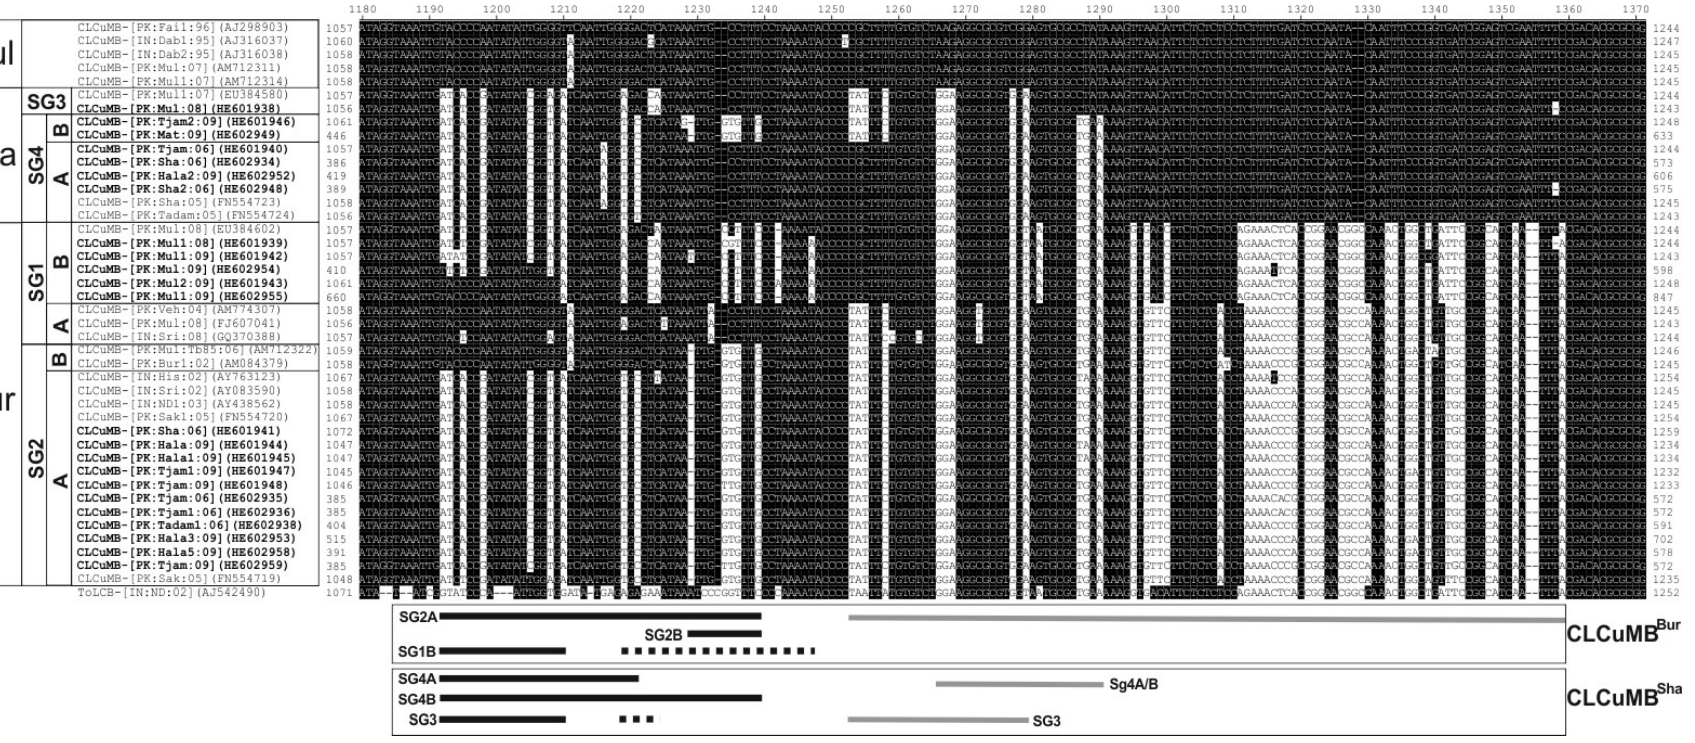
Figure 2. Alignment of the nucleotide sequences of the satellite conserved region (SCR) of CLCuMB isolates derived from the study presented here (highlighted with bold text) with selected sequences from the database. The defective isolates were included in this analysis. The homologous sequence of a Tomato leaf curl betasatellite (ToLCB) isolate was included for comparison. Gaps (-) were introduced into sequences to optimize the alignment. In each case, the isolate descriptor and accession number is given. Sequences differing from CLCuMB-[PK:Fai1:96] (AJ298903; a CLCuMB Mul isolate) are highlighted as black text on a white background. The strain of CLCuMB (Burewala [Bur], Multan [Mul] or Shahdadpur [Sha]) is shown on the left as well as the subgroups (SG) identified in Figure 1. The origins of sequences are shown in the two boxes below the alignment for the recombinant CLCuMB isolates (CLCuMB Bur and CLCuMB Sha ). Sequences likely originating from ToLCB are shown with grey bars. Sequences homologous to those of CLCuMB Bur are indicated by solid black bars. Sequences of unknown origin are shown by dashed black lines. All other sequences are homologous to CLCuMB Mul